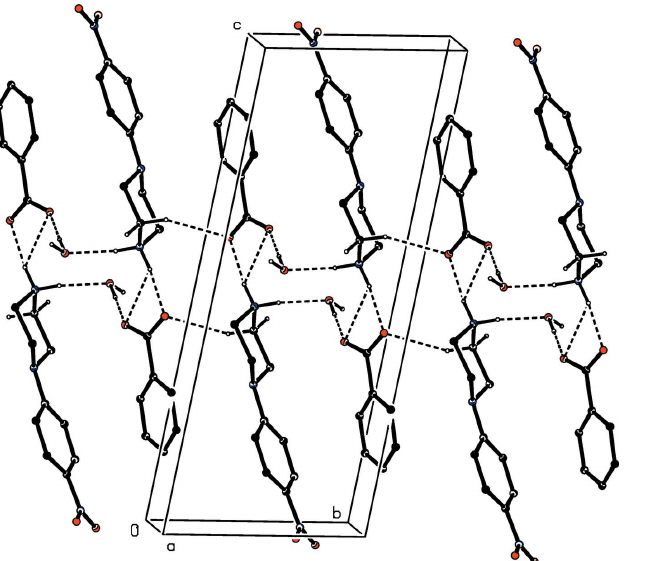
Figure 5 Part of the crystal structure of compound (II), showing the formation of a hydrogen-bonded chain of rings running parallel to [010]. Hydrogen bonds are drawn as dashed lines and, for the sake of clarity, the H atoms bonded to C atoms have all been omitted.